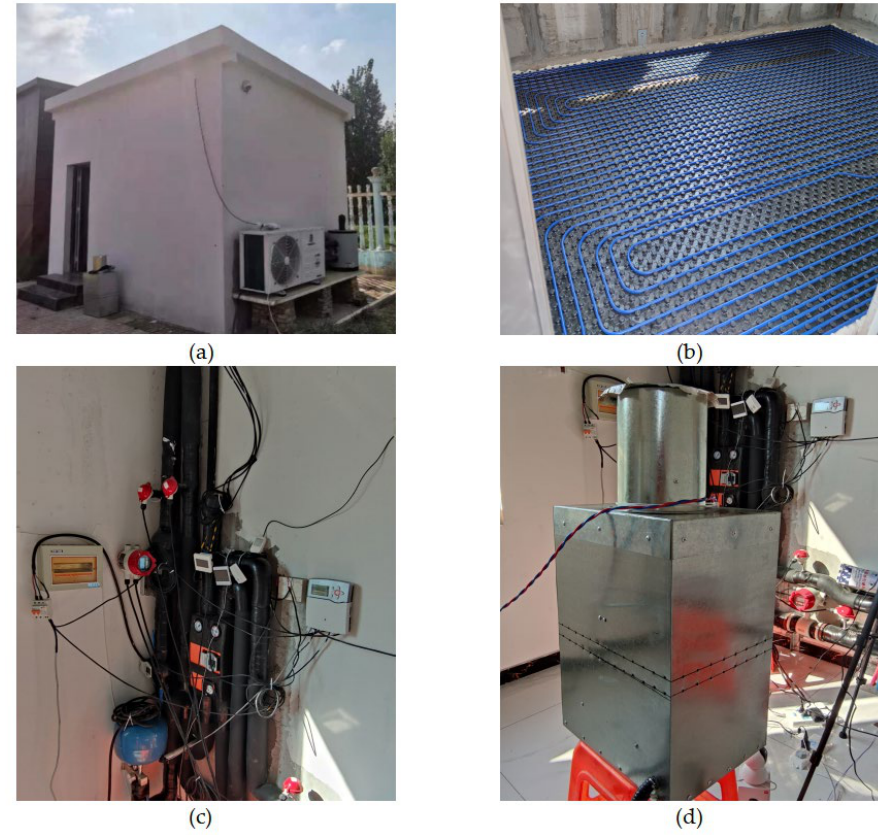
Figure 1. Photographs of the floor plan and experimental building. ( a ) Experimental site, ( b ) pipe with counter flow type laying, ( c ) control system components, and ( d ) indoor heat source.